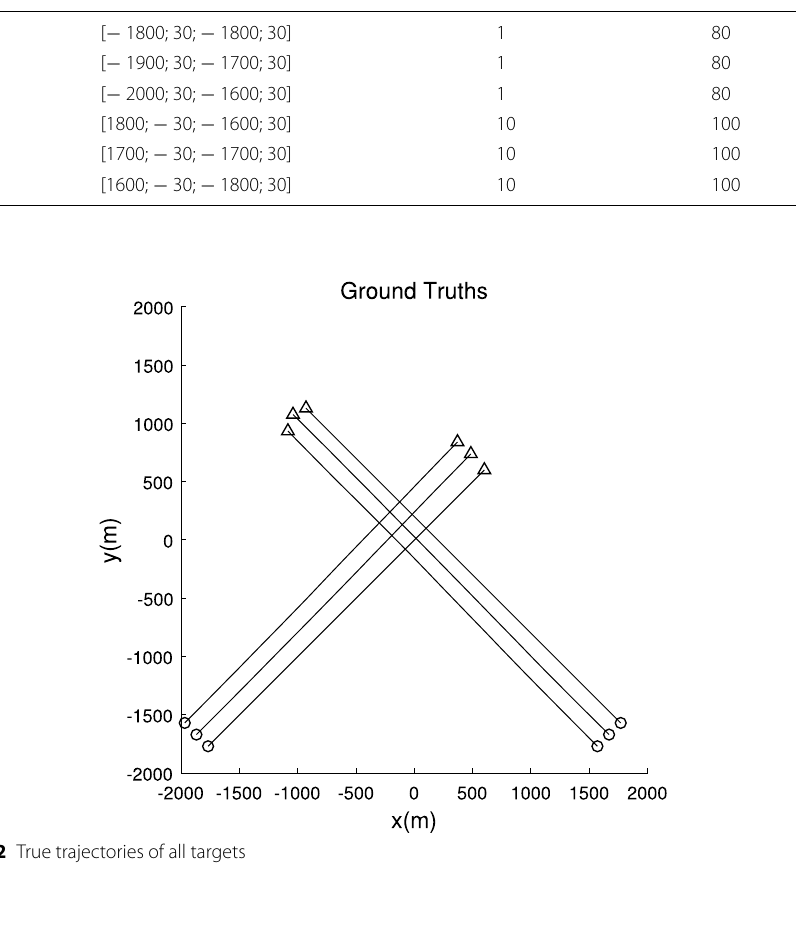
Table 3 Target initial states and birth/death time Targets